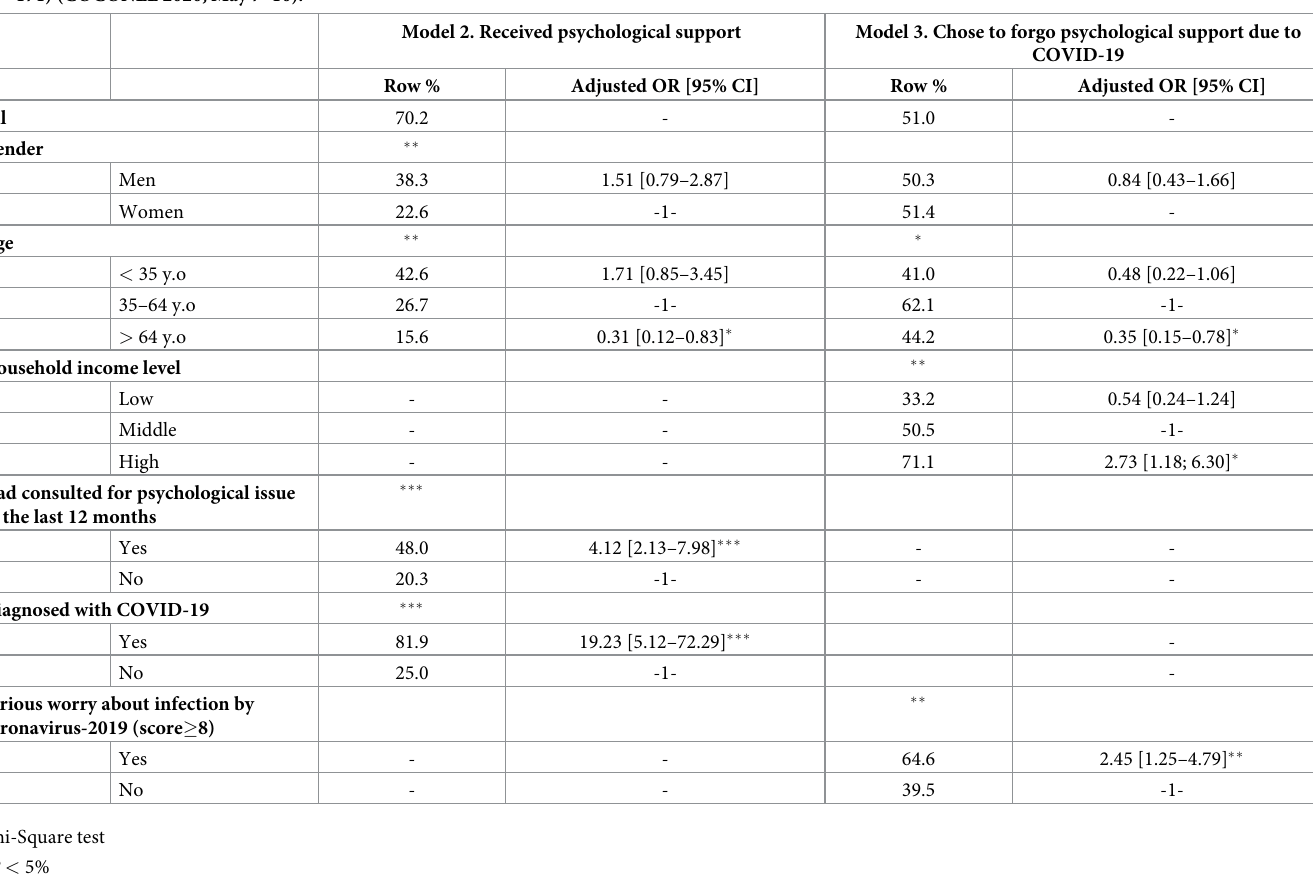
Table 3. Factors associated with lack of psychological support (Model 2, N = 245) and especially with forgoing support for reasons due to COVID-19 (Model 3, N = 171) (COCONEL 2020, May